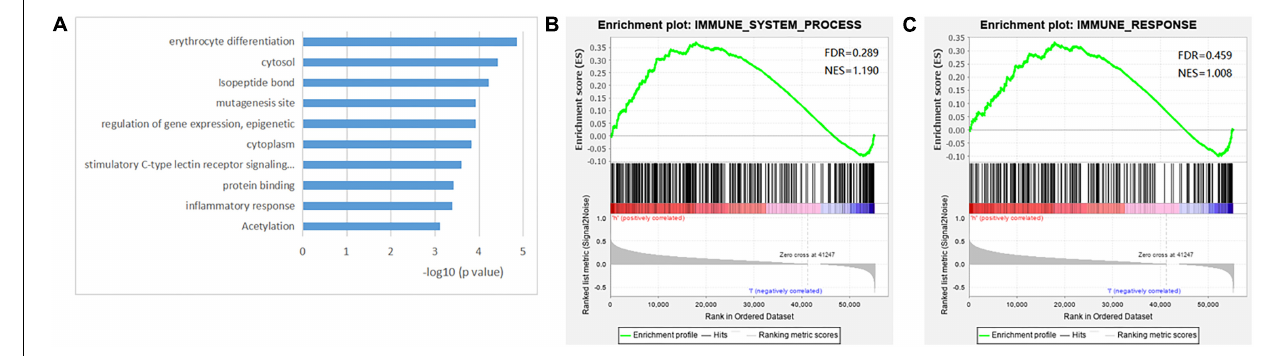
FIGURE 5 | Gene set enrichment analysis (GSEA) of the four immune lncRNA signature dataset. (A) The top 10 biological processes and signaling pathway. GSEA validated enhanced activity of immune system progress gene set (B) and immune response gene set (C)